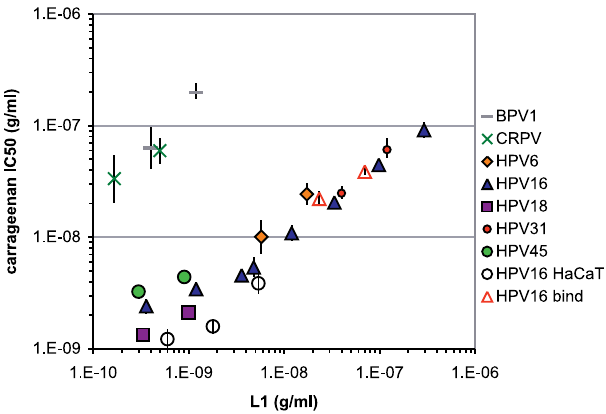
Figure 4. Standardized Carrageenan IC 50 for Various Papillomavirus Types Points represent carrageenan IC 50 of infectivity, except for empty red triangles, which represent the carrageenan IC 50 of cell binding for HPV16 capsids covalently linked to a fluorescent dye. Empty circles represent carrageenan IC 50 of infectivity observed using HaCaT cells instead of HeLa cells. Error bars represent the 95% CI for the IC 50 . DOI: 10.1371/journal.ppat.0020069.g004